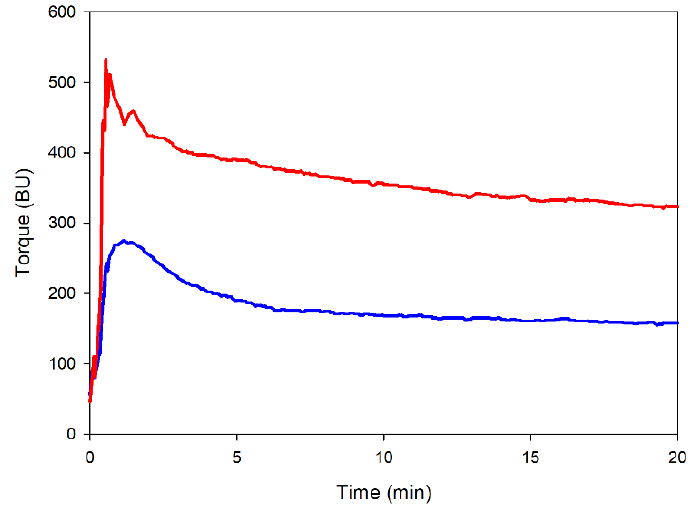
Figure 4. Mixing properties of raw (blue line) and heat-treated (red line) flours from red lentils at 50% hydration level. BU: Brabender Units.